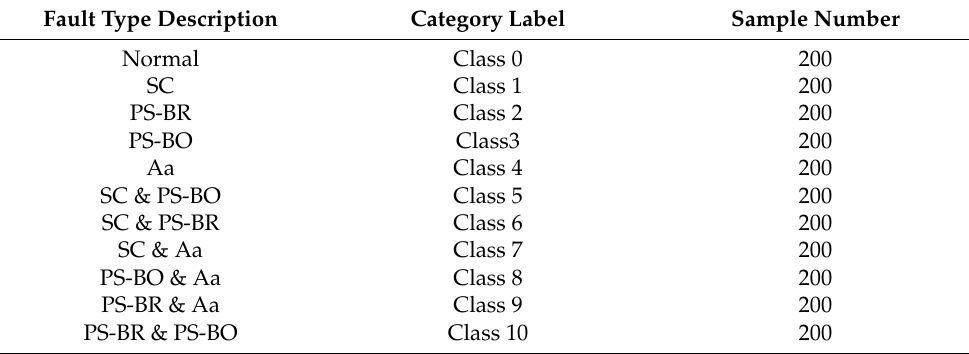
Table 2. Summary of measured experimental fault type.